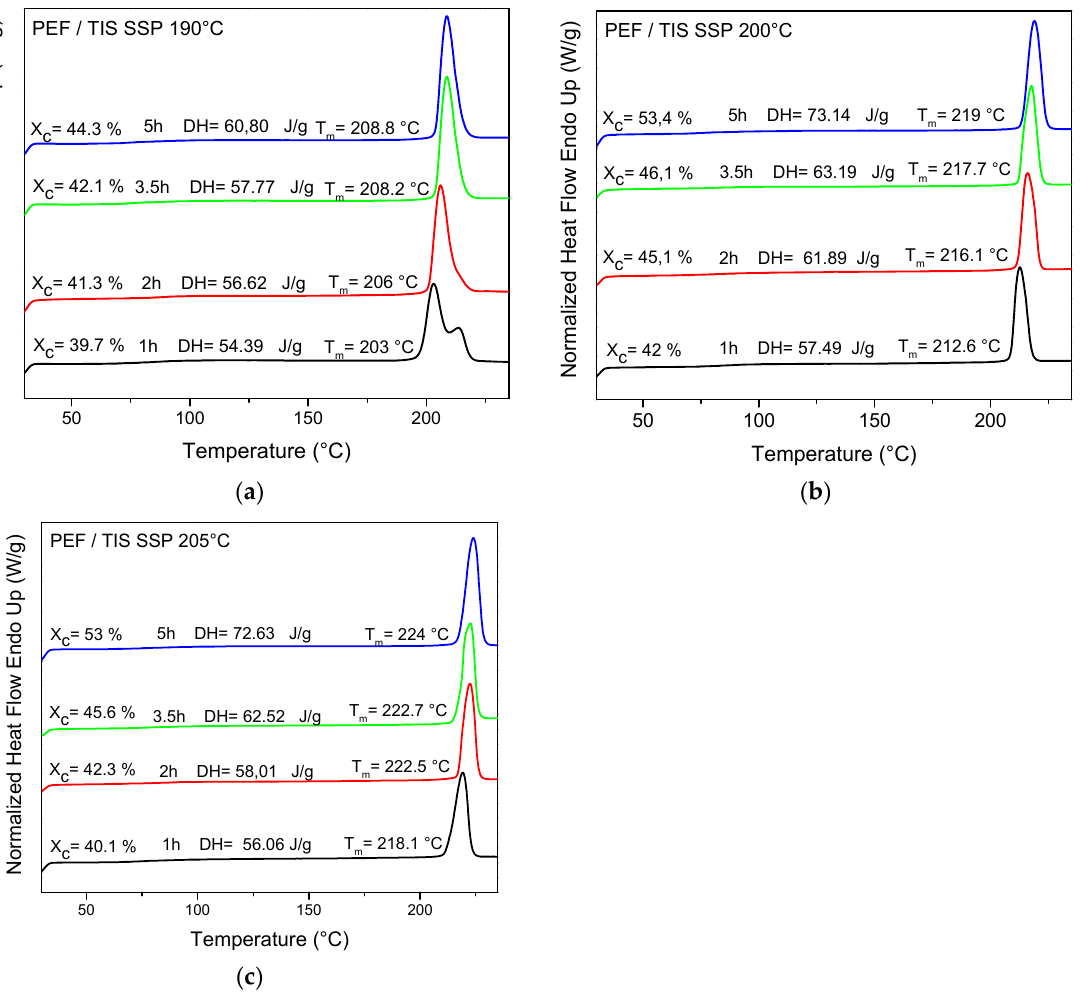
Figure 7. DSC thermograms of PEF/TIS samples prepared after SSP at different temperatures and times: ( a ) 190 °C, ( b ) 200 °C and ( c ) 205 °C.